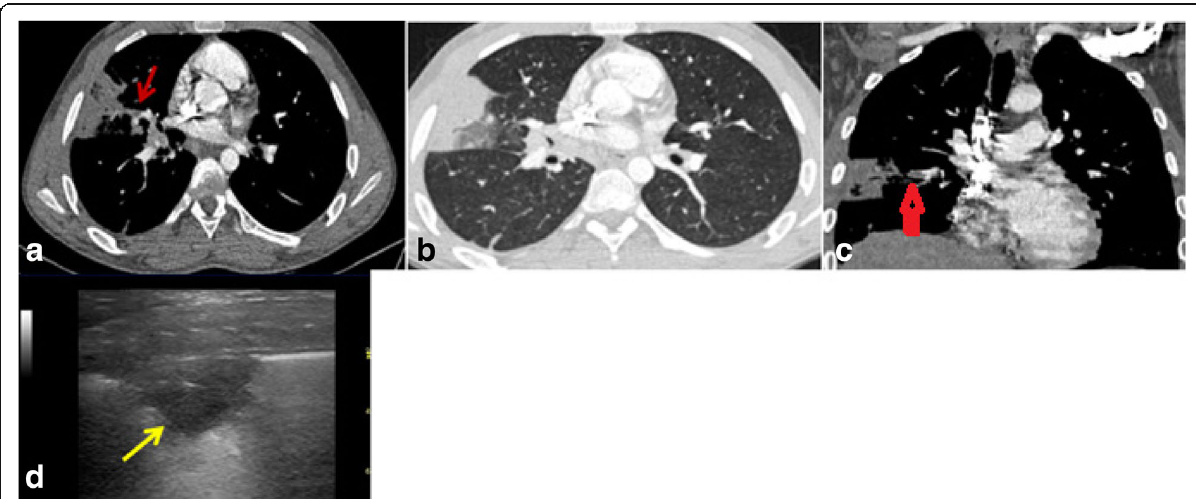
Fig. 4 CT pulmonary angiography ( a – c ) and ultrasound ( d ) images. a An axial section in the mediastinal window showing a small filling defect seen within the middle lobe lateral segmental branch. b An axial section in the lung window showing subsequent distal pleural-based wedge- shaped opacity. c Coronal section in the mediastinal window showing a filling defect in the middle lobe lateral segmental branch ( open red arrow ), that is related to the middle lobe pleural-based opacity. d An ultrasound image in B-mode showing a right middle lung zone pleural-